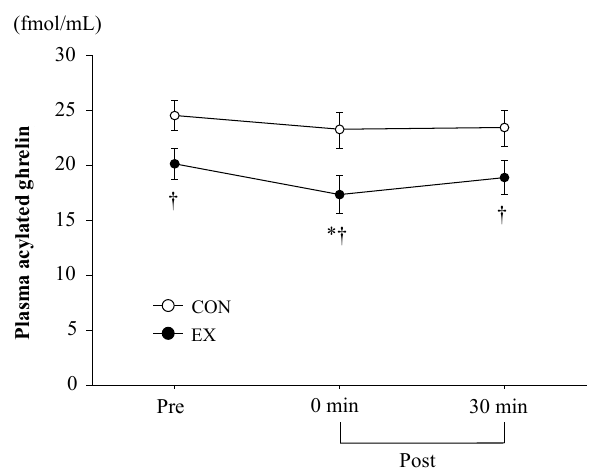
Figure 1. Change in plasma acylated ghrelin concentrations. Values are means ± SE. * p < 0.05 vs. pre, † p < 0.05 vs. CON.